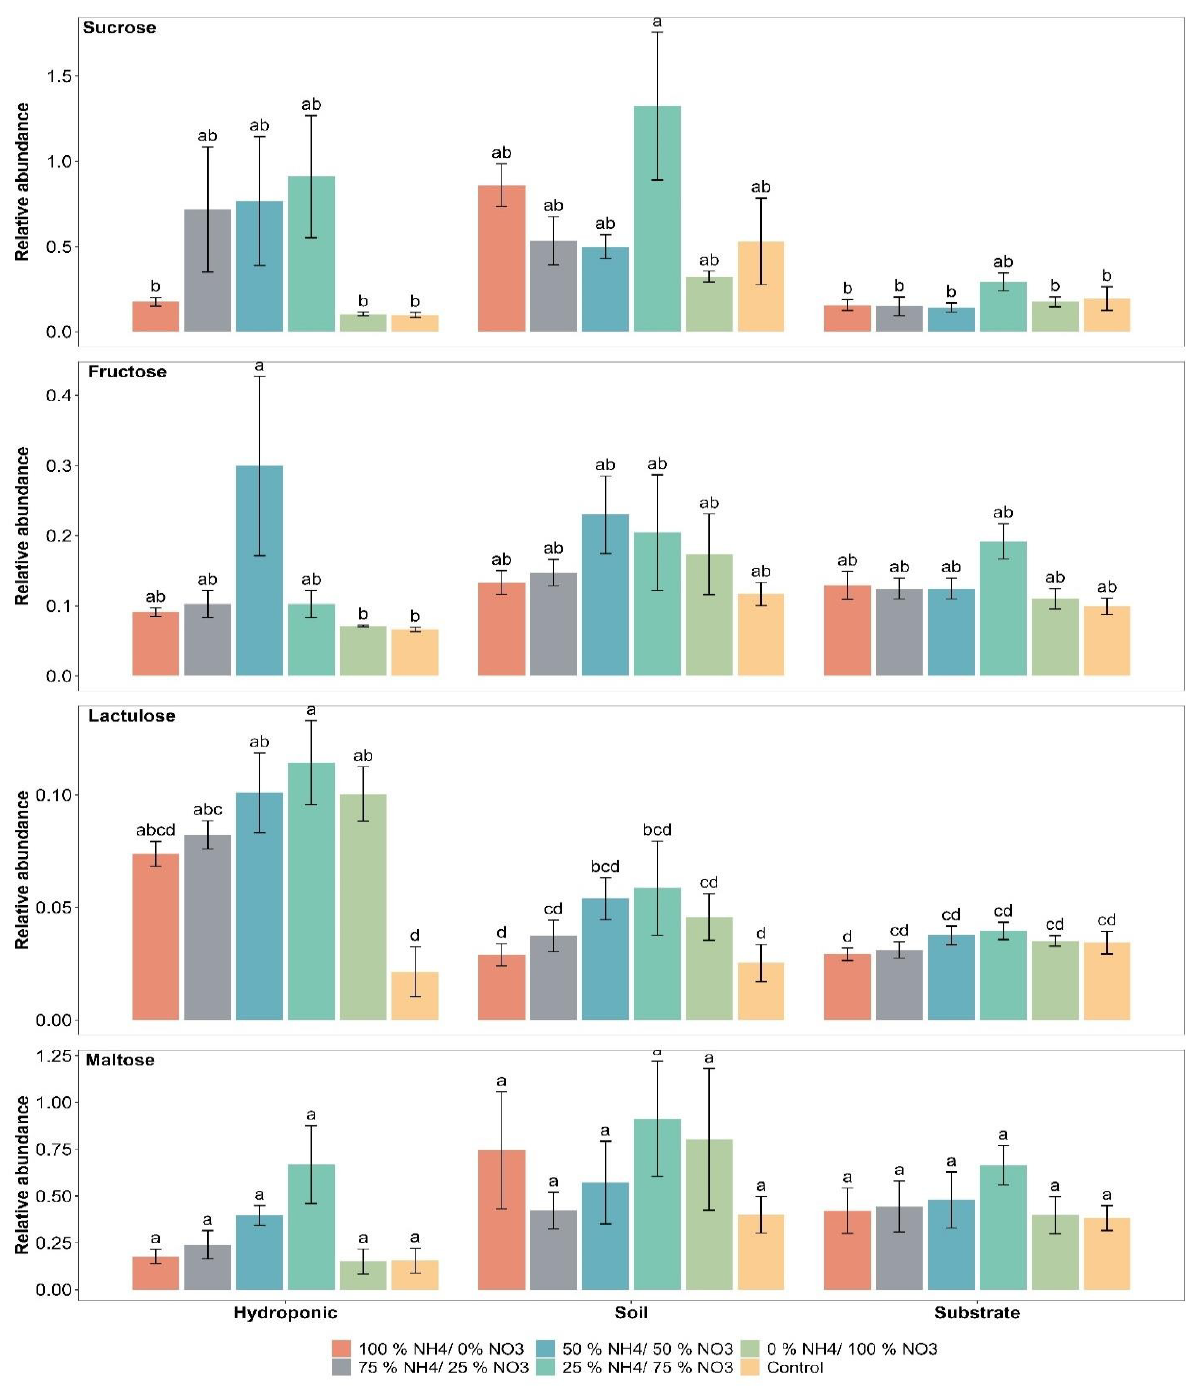
Figure 4. Effect of various applied NH 4+ /NO 3 − ratios (100:0, 75:25, 50:50, 25:75 and 0:100%) and control (no additional N applied) on sugar compounds in lettuce grown in soil, substrate and hydroponic cultivation systems. Note- The means ( n = 4) ± standard errors are shown in the data. Different letters (a–d) show significant difference ( p = 0.01) among applied NH 4+ /NO 3 − ratios (100:0, 75:25, 50:50, 25:75 and 0:100%) and control in lettuce grown in soil, substrate and hydroponic cultivation